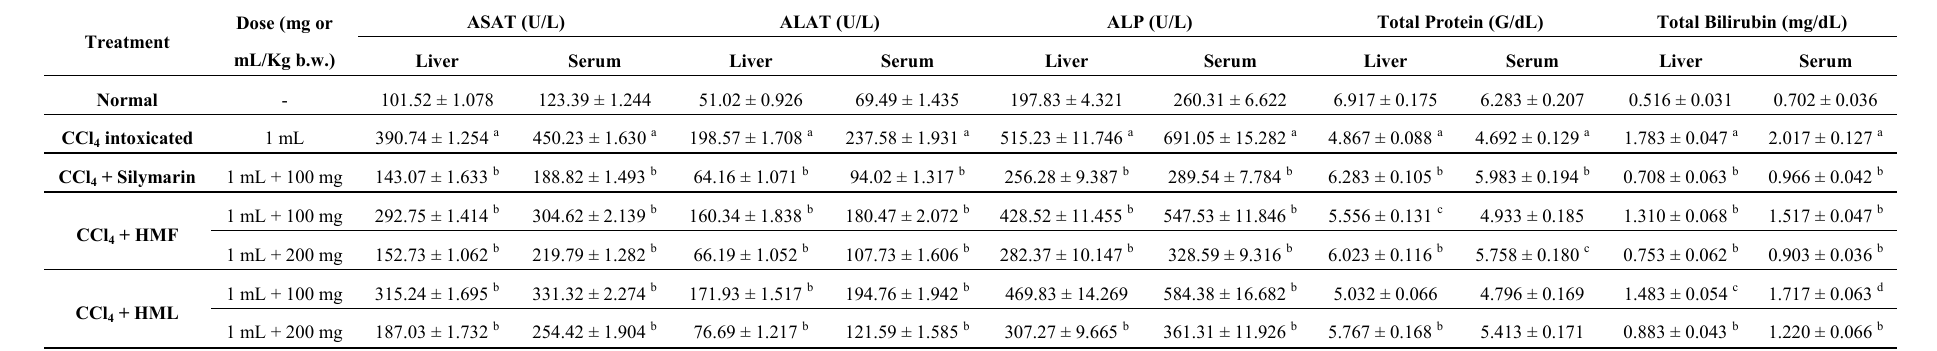
-intoxicated groups. b p < 0.001, c p < 0.01, d p < 0.05, between the CCl 4